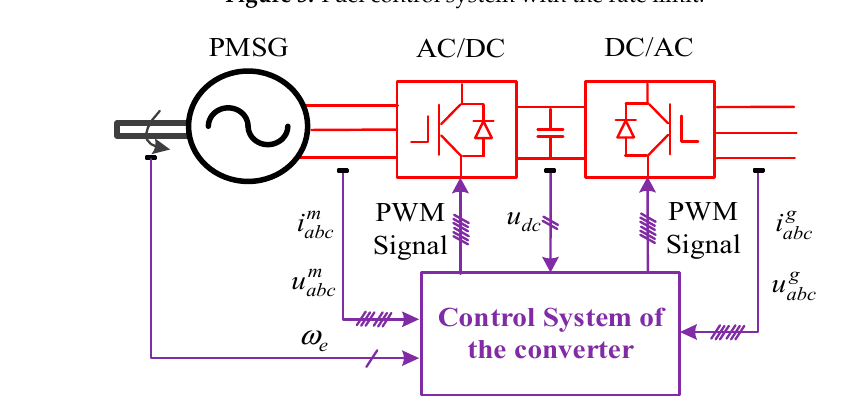
Figure 4. Structure of the converter control system.